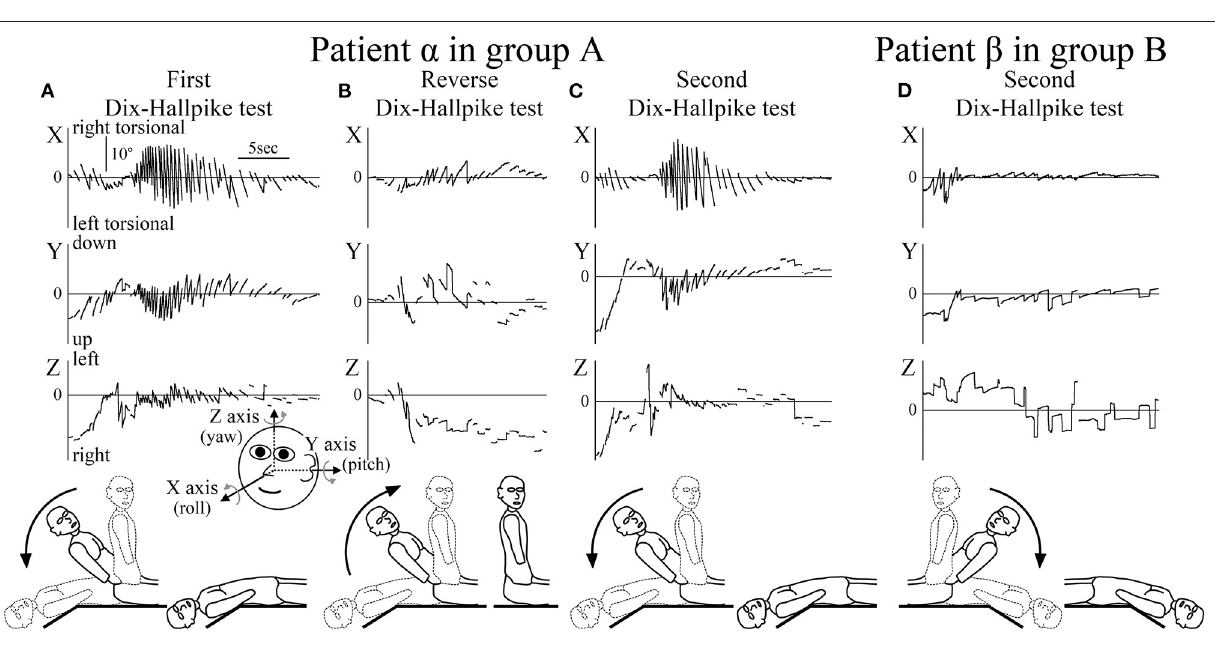
FIGURE 2 | Axis angles of the eye position of the positional nystagmus. (A–C) Patient α allocated to group A. (D) Patient β allocated to group B. (A) Axis angle of the eye position of the positional nystagmus induced by the first right Dix–Hallpike test. A strong right torsional (X component), upward (Y component), and leftward (Z component) positional nystagmus was observed. Inserted figure of the face shows the three-dimensional (3D) coordinates used. (B) Axis angle of the eye position of the positional nystagmus induced by the reverse Dix–Hallpike test. Left torsional and downward positional nystagmus were observed. The direction of the positional nystagmus was opposite to that induced by the first right Dix–Hallpike test (A) . (C) Axis angle of the eye position of the positional nystagmus induced by the second right Dix–Hallpike test. A similar strong positional nystagmus to that induced by the first Dix–Hallpike test (A) was observed. (D) Axis angle of the eye position of the positional nystagmus induced by the second left Dix–Hallpike test. In patient β (allocated to group B), the positional nystagmus induced by the second Dix–Hallpike test was much weaker than that in patient α (group A; Figure 2C ). The nystagmus observed at the initial part was not positional but rather nystagmus induced by